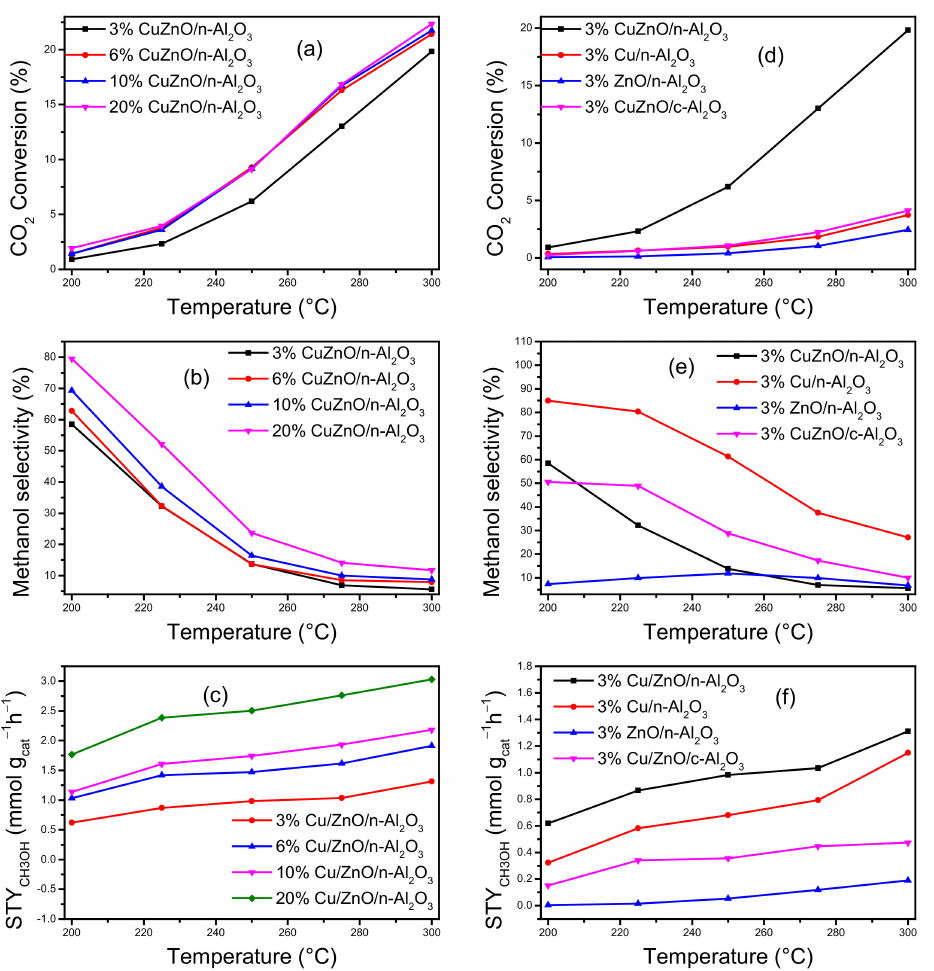
Figure 5. CO 2 hydrogenation performances of catalyst samples. ( a ) CO 2 conversion, ( b ) CH 3 OH selec- tivity, and ( c ) STY CH3OH of CuZnO with various loadings, supported on n-Al 2 O 3 . ( d ) CO 2 conversion, ( e ) CH 3 OH selectivity, and ( f ) STY CH3OH of 3% Cu, 3% ZnO, and 3% CuZnO on n-Al 2 O 3, and 3% CuZnO on c-Al 2 O 3 . Reaction conditions: GHSV = 7800 mL g − 1 h − 1 , gas flow rate = 13 mL min − 1 , CO 2 :H 2 = 1:3, P = 3.0